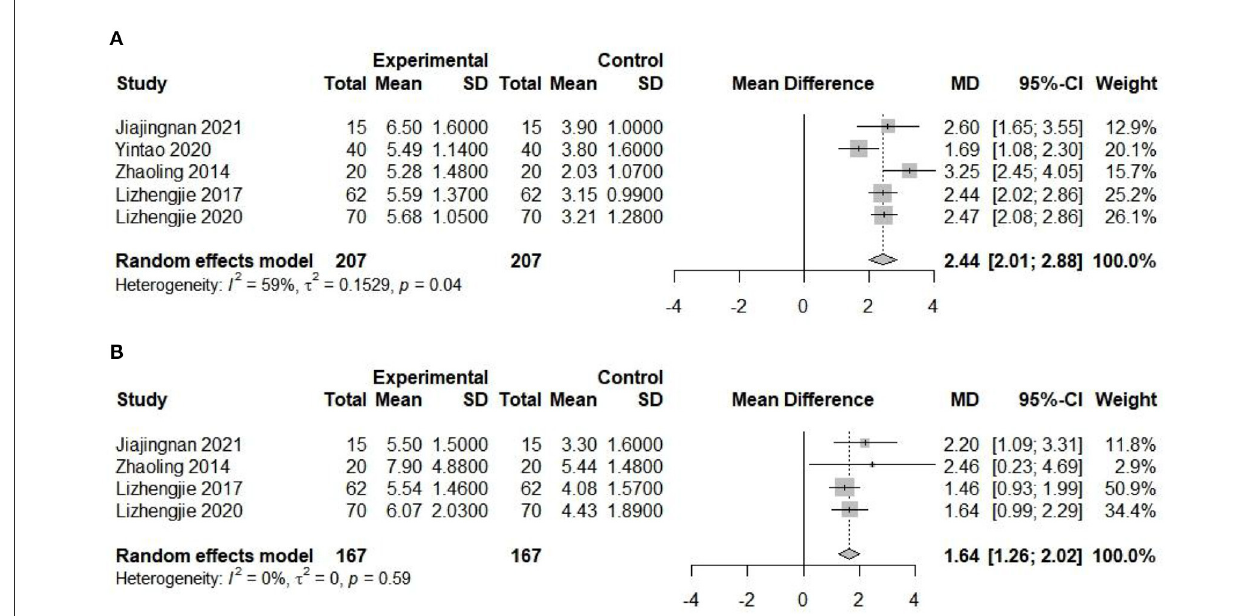
FIGURE9 Forest plot presenting the study meta-analysis for the (A) VAS scale. (B) head